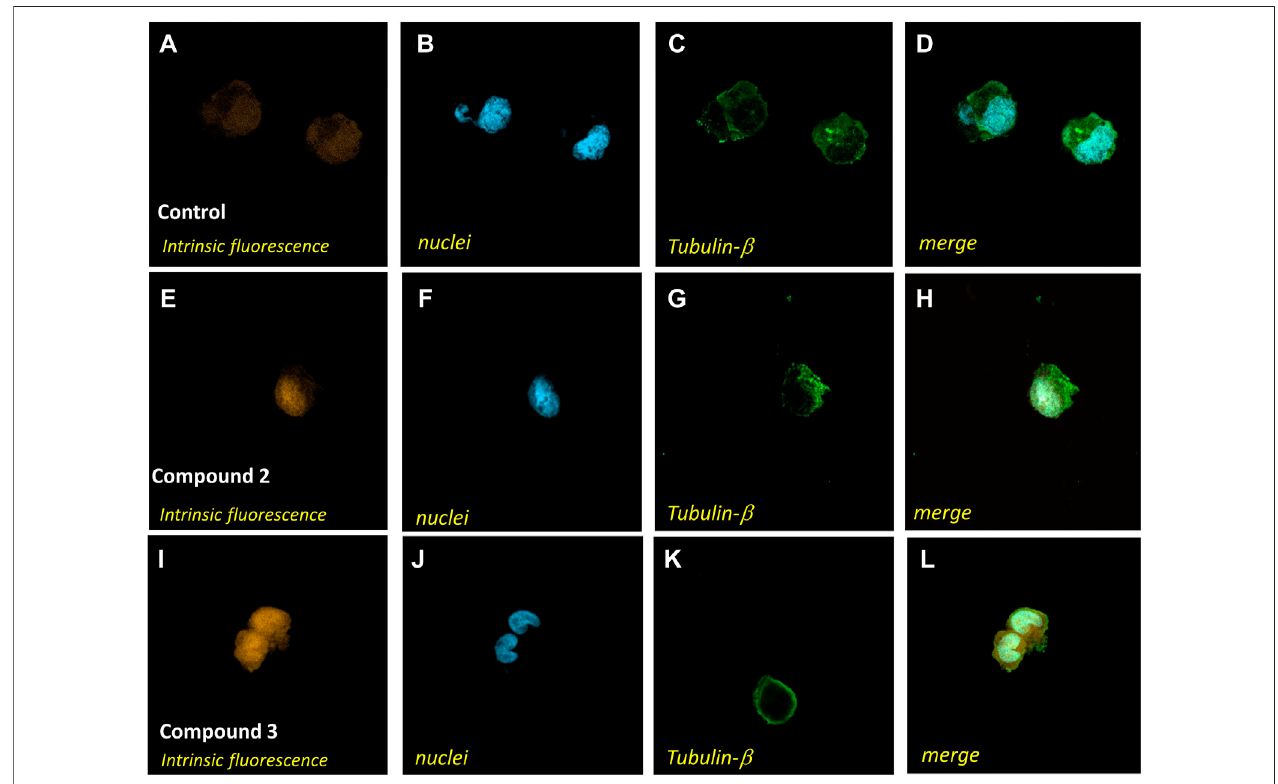
FIGURE 7 | Confocal microscopy analysis of A2780 cells treated with complex 2 or 3 . A2780 cells were incubated in standard conditions (A – D) , for 4 h with compound 2 at a 75 μ M concentration (E – H) , or for 35 min with compound 3 at a 75 μ M concentration (I – L) and stained with Alexa Fluor 488 Mouse anti- β -tubulin antibody and DAPI to identify the cytoplasmatic compartment (C,G,K) and nuclei (B,F,J) . Intrinsic fl uorescence in A , E , and I